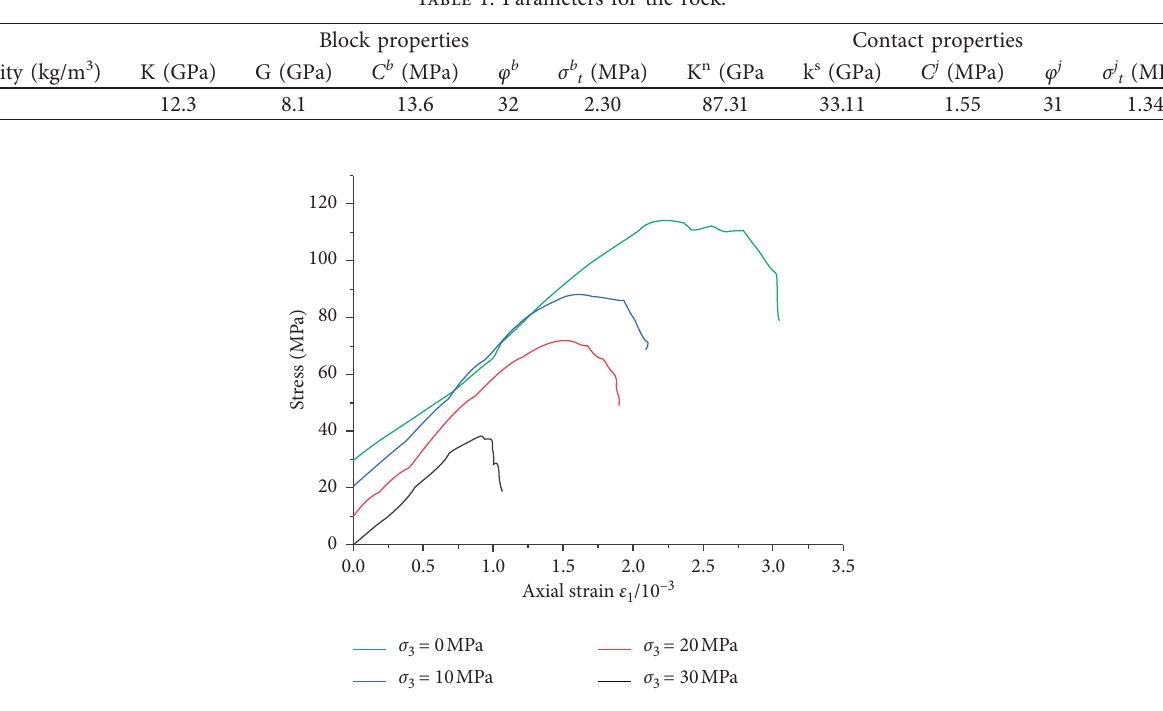
Figure 21: Stress-strain curves of